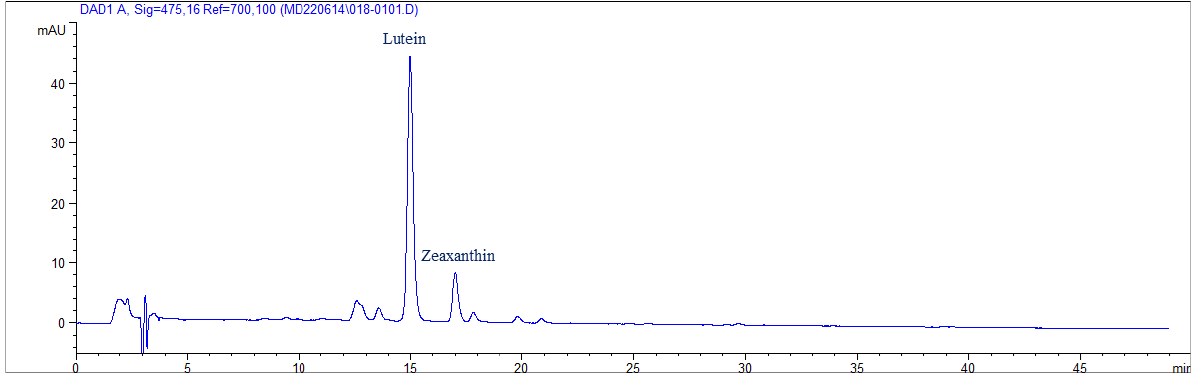
Figure A3. Representative chromatogram of carotenoids identified on the basis of RT and absorption spectra in the extracts of Svevo, Svevo HA, Faridur, Chifaa and lentil 6002/ILWL118/1-1.